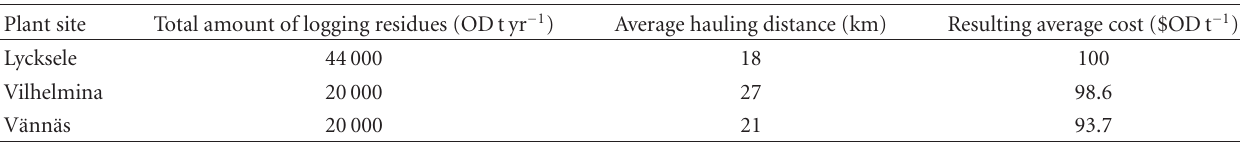
Table 5: Amount of logging residues required, average hauling distance (km), and average cost for logging residue provision ($OD t − 1 ) for the production of 15 000 ODt of either fuel pellets or pellet